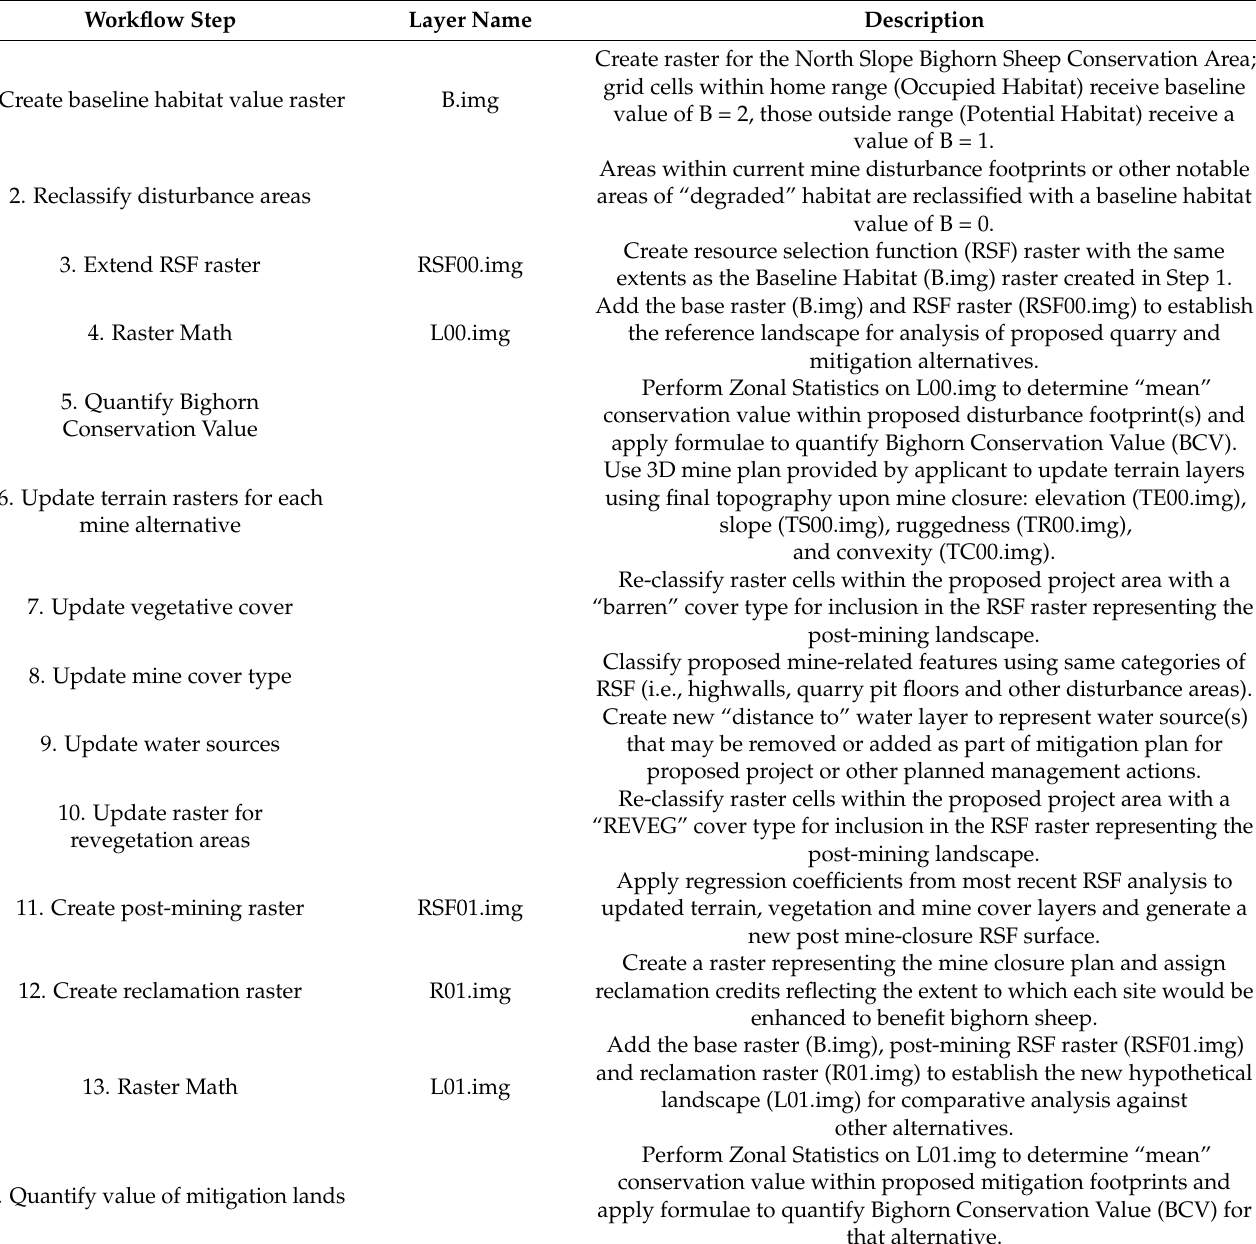
Table A4. Proposed geoprocessing workflow of the Bighorn Habitat Assessment Tool